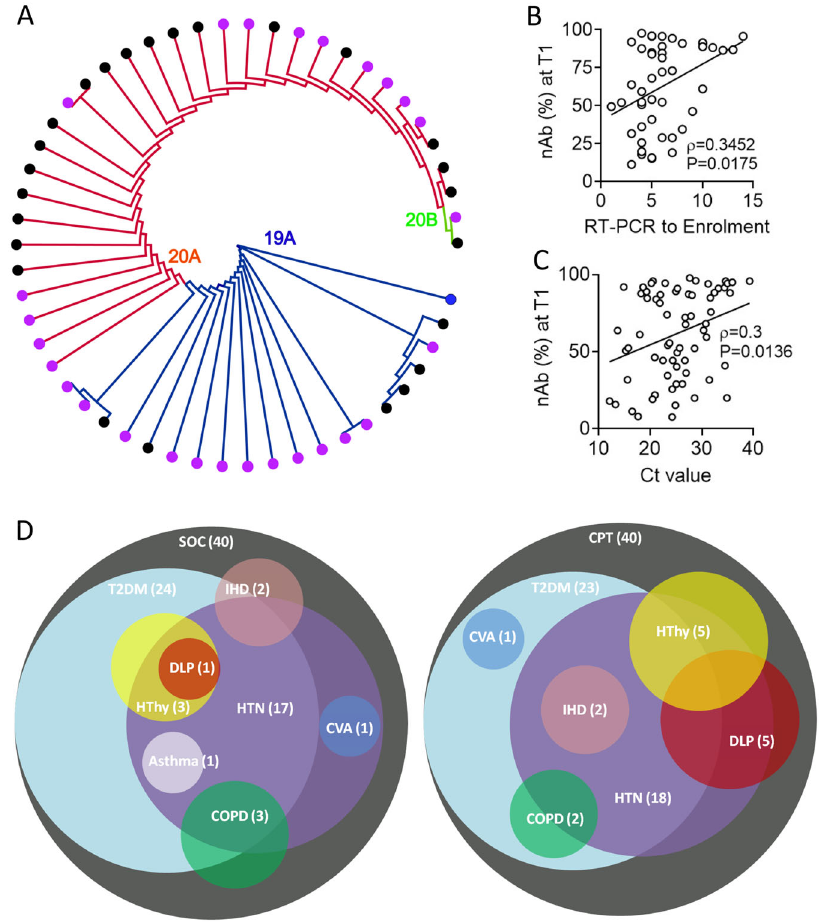
Fig. 3 Key pathogen and host characteristics and primary clinical outcomes. A The whole-genome phylogenetic tree of SARS-CoV-2 viral isolates from SOC and CPT groups. Black and purple tips represent the samples from SOC and CPT groups. B Correlation between the neutralizing antibody content of plasma at T1 and day since the patients were tested positive on RT-PCR. C Correlation between the neutralizing antibody content of plasma at T1 and CT values obtained from SARS-CoV-2 RT-PCR from nasopharyngeal swabs collected at T1 is shown. D Venn diagram showing distribution of different co- morbid conditions among the patients in SOC and CPT